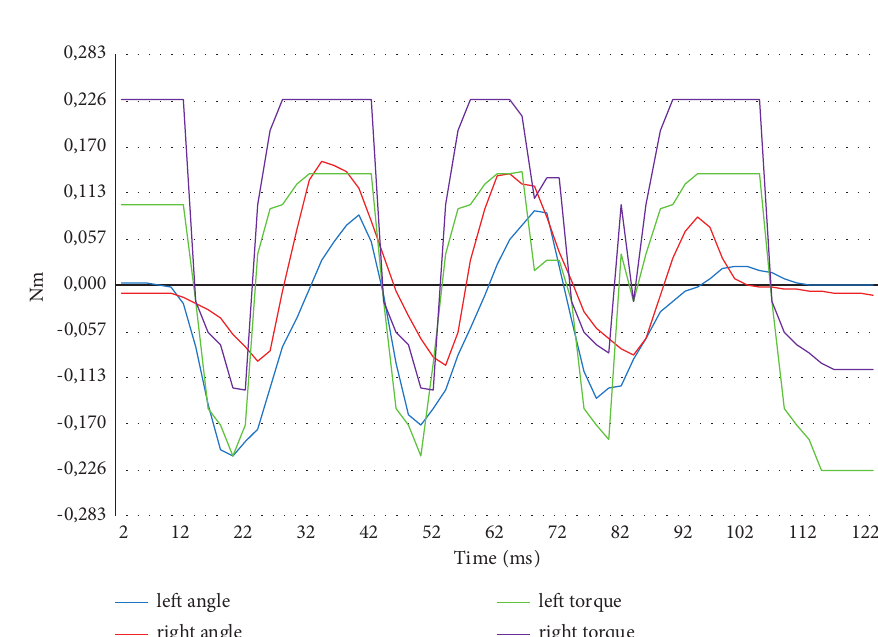
Figure 11: Assistive torque generated for the left and right hip joints with a wider swing